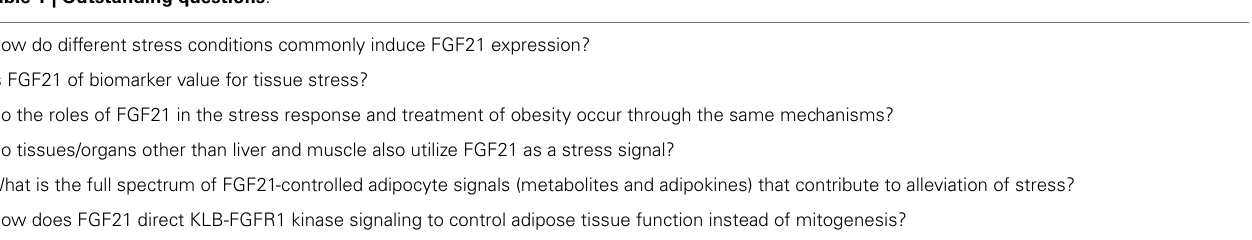
Table 1 | Outstanding questions